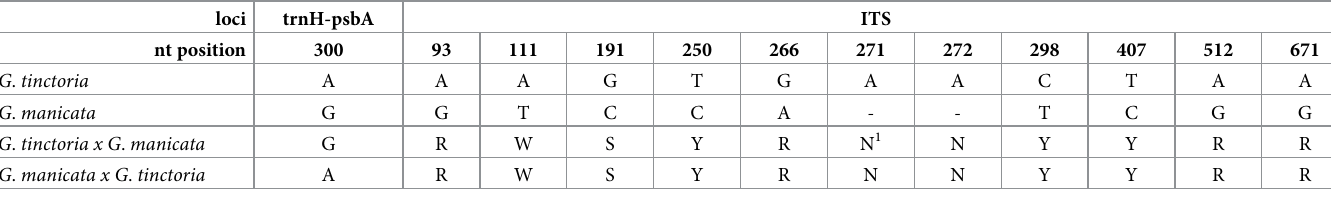
Table 4. Nucleotide differences between G . tinctoria , G . manicata and their hybrids for the trnH-psbA spacer en ITS loci. loci trnH-psbA ITS nt position